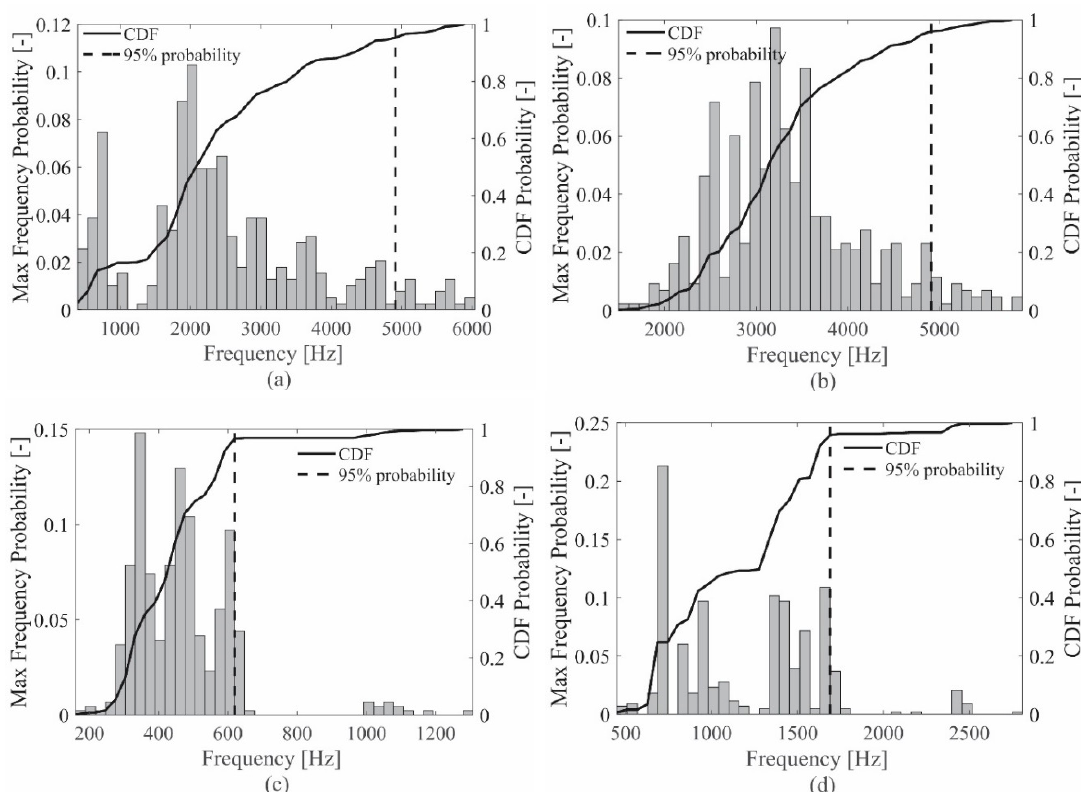
Figure 4. CDF and 95% limit for the ACC on the aluminum plate ( a ) and the sandwich panel ( b ) and for the PZT on the aluminum plate ( c ) and the sandwich panel ( d ). Table 4. Identified significant cutoff frequencies for the ACC and PZT sensor, on both specimens. ACC—Al